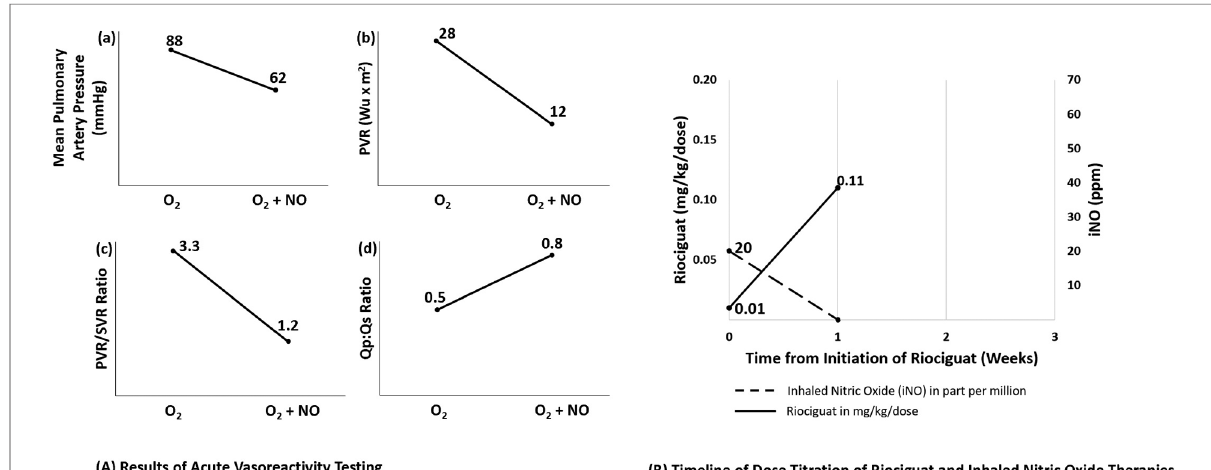
FIGURE 2 Results of acute vasoreactivity testing and timeline of dose titration of riociguat and inhaled nitric oxide therapies for patient 2. ( A ) Results of acute vasoreactivity testing for patient 2. Acute challenge with increased oxygen (FiO2 1.0) and addition of inhaled nitric oxide at 40 ppm resulted in signi fi cant improvement of ( A ) mean pulmonary artery pressure, ( B ) indexed pulmonary vascular resistance, ( C ) PVR:SVR ratio and ( D ) Qp:Qs ratio. ( B ) Timeline for initiation of riociguat therapy and weaning off inhaled nitric oxide. Patient 2 was started on riociguat 0.01 mg/kg/dose (0.05 mg total dose three times per day) with a daily dose increase, achieving 0.5 mg/dose TID after 1 week. Nitric oxide was weaned over that same week to off without adverse clinical sequelae noted. Not shown, his dose was titrated up to 2 mg TID over the subsequent four months. O 2 , oxygen; NO, inhaled nitric oxide; PVRi, indexed pulmonary vascular resistance; PVR, pulmonary vascular resistance; SVR, systemic vascular resistance; Qp, pulmonary fl ow; Qs, systemic fl